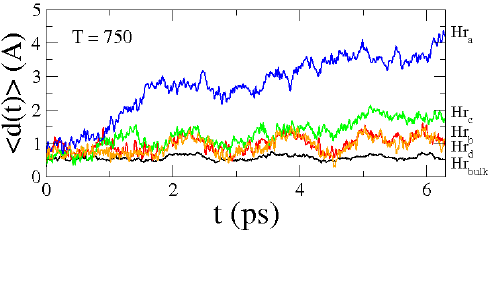
Figure 9. Average displacements ⟨ d ( t ) ⟩ of the group of H atoms Hr line), Hr (green line), Hr c T = 750 K, for the “new”